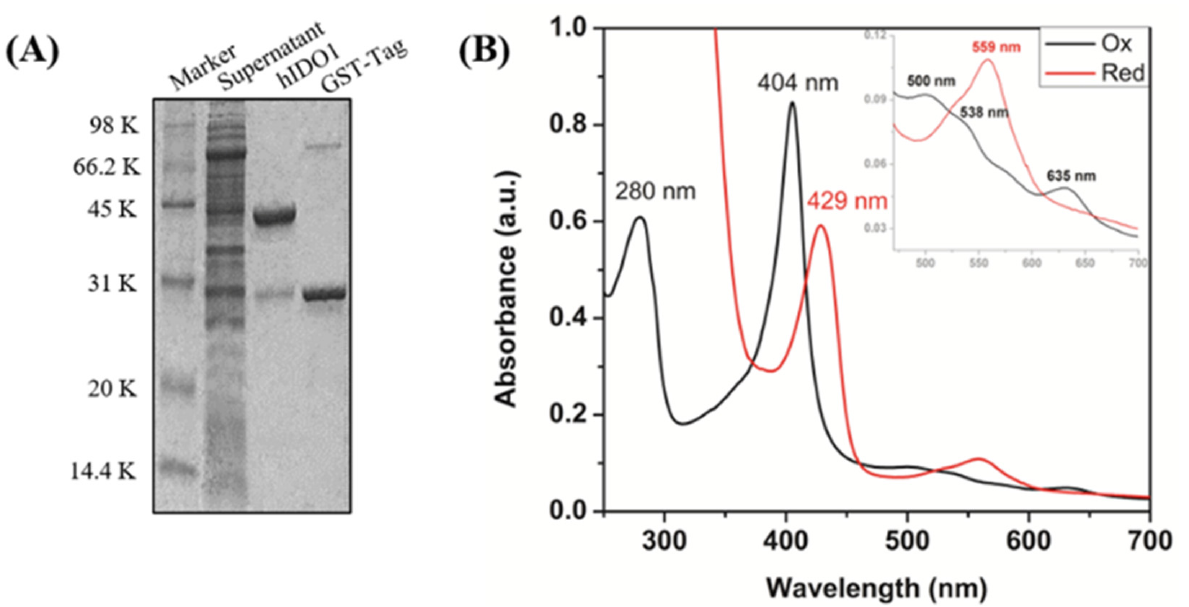
Figure 2. ( A ) Identification of IDO1 in expression and purification. The SDS-PAGE gel shows that GST-IDO1 is soluble after expression and appeared in supernatant with a molecular weight of over 66.2 kD. The strip of target protein is presented at 45 kD after removing the GST-tag. ( B ) UV–vis spectra of IDO1 in ferric and ferrous forms.